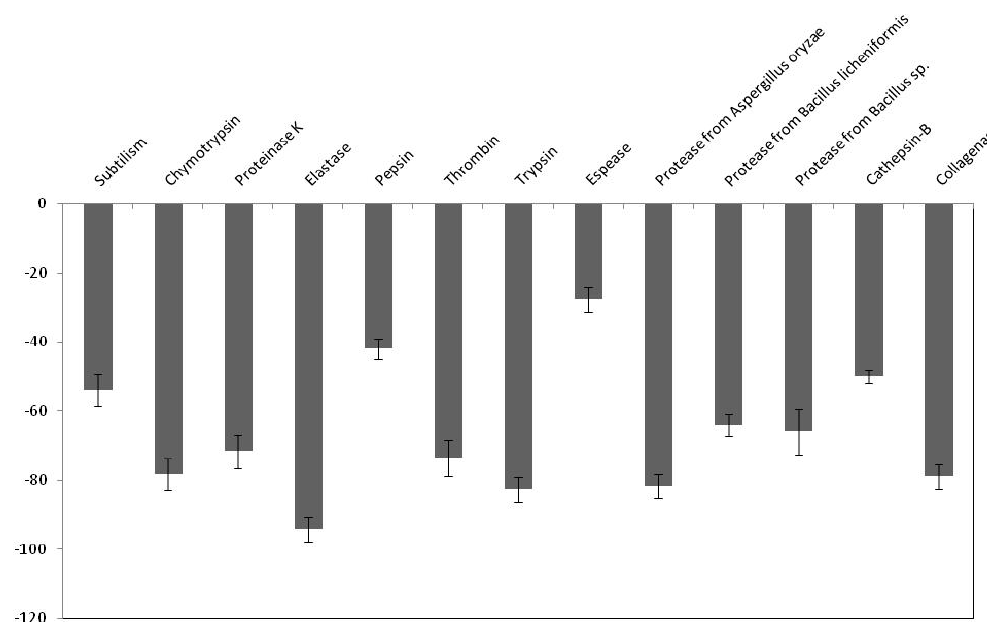
Figure 6. Inhibitory activity of PDInhibitor toward several proteases with pharmaceutical and commercial importance. Data are the means of triplicate determinations ± SD.